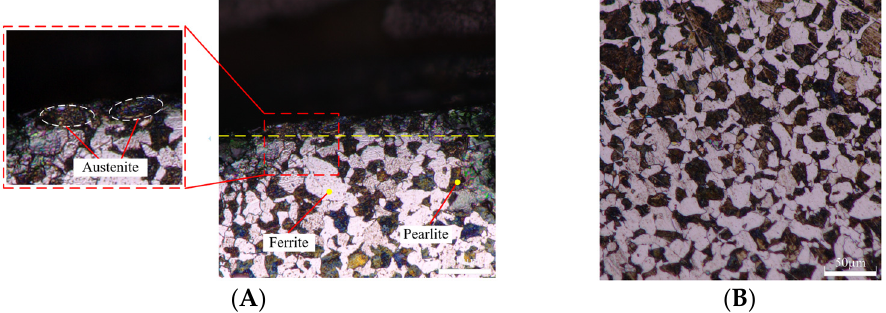
Figure 15. Metallographic morphology of metamorphic layer and surface. ( A ) Metallographic mor- phology of metamorphic layer. ( B ) Metallographic morphology of surface. morphology of metamorphic layer. ( B ) Metallographic morphology of surface.